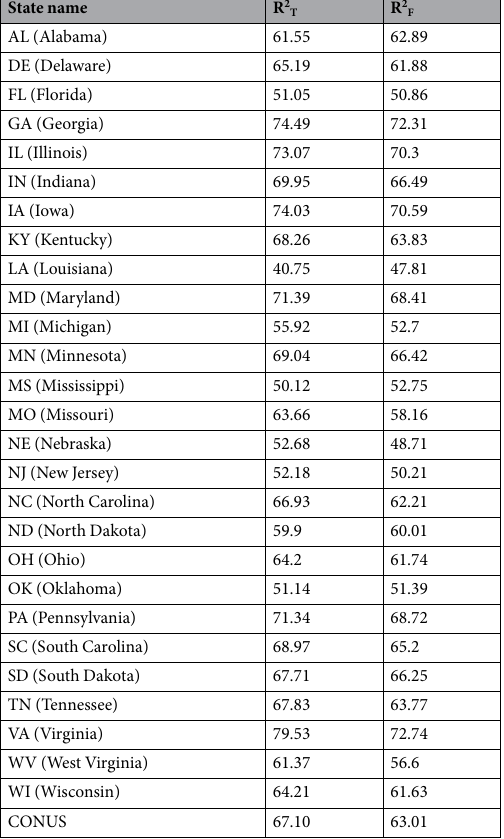
Table 1. Portion of corn yield variability explained by growing season climate variability during 1970–1999 by the empirical models with (R 2 T ) and without (R 2 F ) considering the changes in crop growing pattern. Note: only states where the climate-corn yield relations are statistically significant at the 95% confidence level are included for investigation. The value for CONUS is the average over investigated states with weights based on the corn